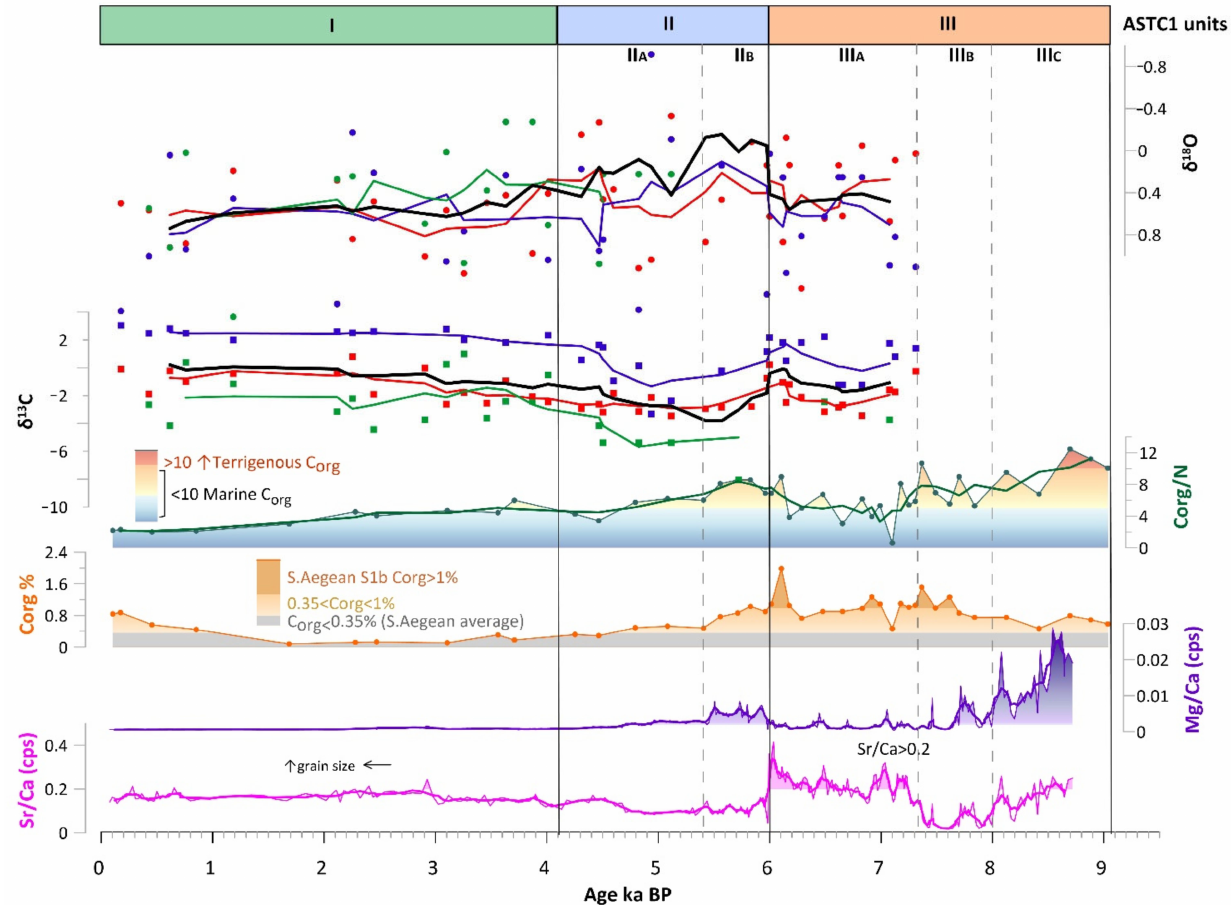
Figure 7. Synthetic plot of ASTC1 sediment core proxy record. From botttom to top: Sr/Ca (cps) and Mg/Ca (cps) geochemical ratios, total organic carbon content (%TOC) and TOC/TN (%), stable iso- topes ( δ 13 C and δ 18 O), the chronologically adjusted lithological units of ASTC1, and their boundaries marked with the dashed gray line. Red color refers to Ammonia spp., green to ostracods, and purple to Quinqueloculina spp. Dots represent the absolute values of δ 13 C and δ 18 O whereas the colored lines refer to the 5-point running average. The black line refers to the 5-point running average of the mean δ 13 C and mean δ 18 O values. Three point running averages (thick line) were also calculated for Mg/Ca, Sr/Ca, Corg and